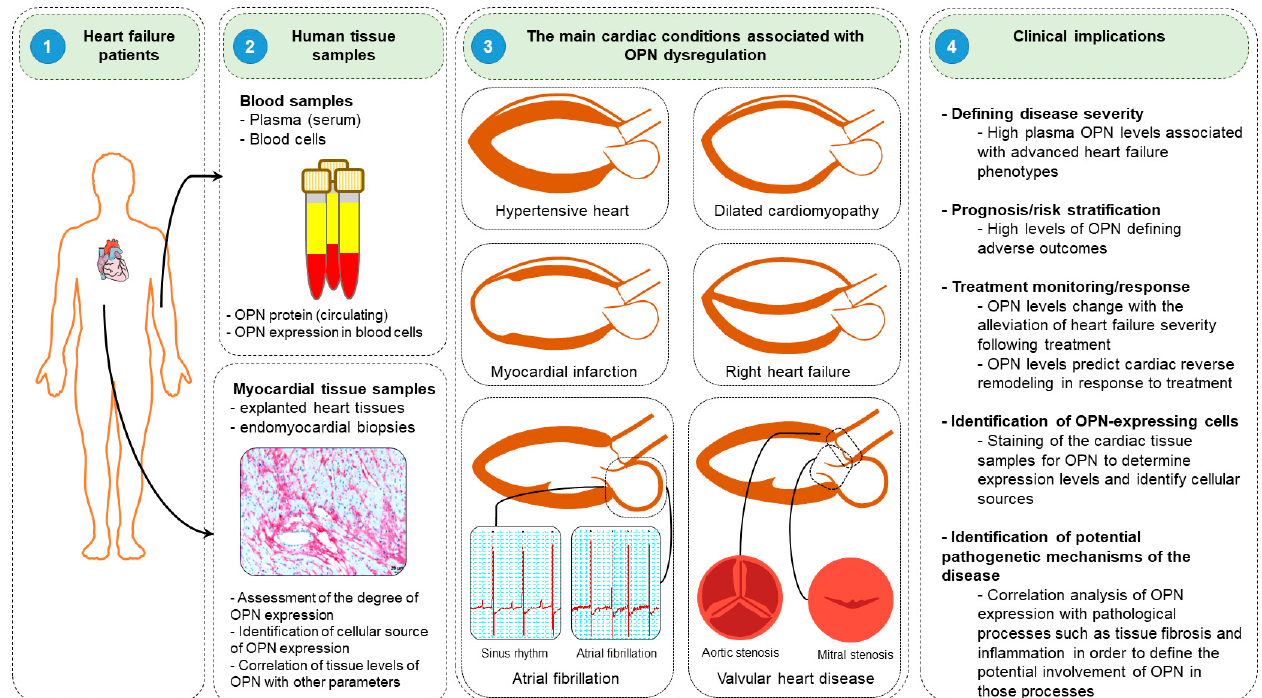
Figure 5. Clinical implications of osteopontin. (1) Blood samples are collected from the peripheral blood, while myocardial tissues are obtained from explanted hearts or endomyocardial biopsies during cardiac catheterization or cardiac surgery. (2) Plasma/serum and blood cells are isolated from blood samples to measure osteopontin (OPN) levels. Similarly, osteopontin expression levels are evaluated and cellular sources of osteopontin are identified in myocardial tissues. (3) Assessment of osteopontin levels might be useful in several cardiac conditions, including hypertensive heart, dilated cardiomyopathy, myocardial infarction, and right heart failure, atrial fibrillation and valvular heart disease. (4) Assessment of osteopontin levels might be useful in determining diseases severity, prognostic/risk stratification, monitoring of treatment response, identification of cellular sources of osteopontin in various cardiac conditions and help to understand the mechanisms of the disease pathogenesis.